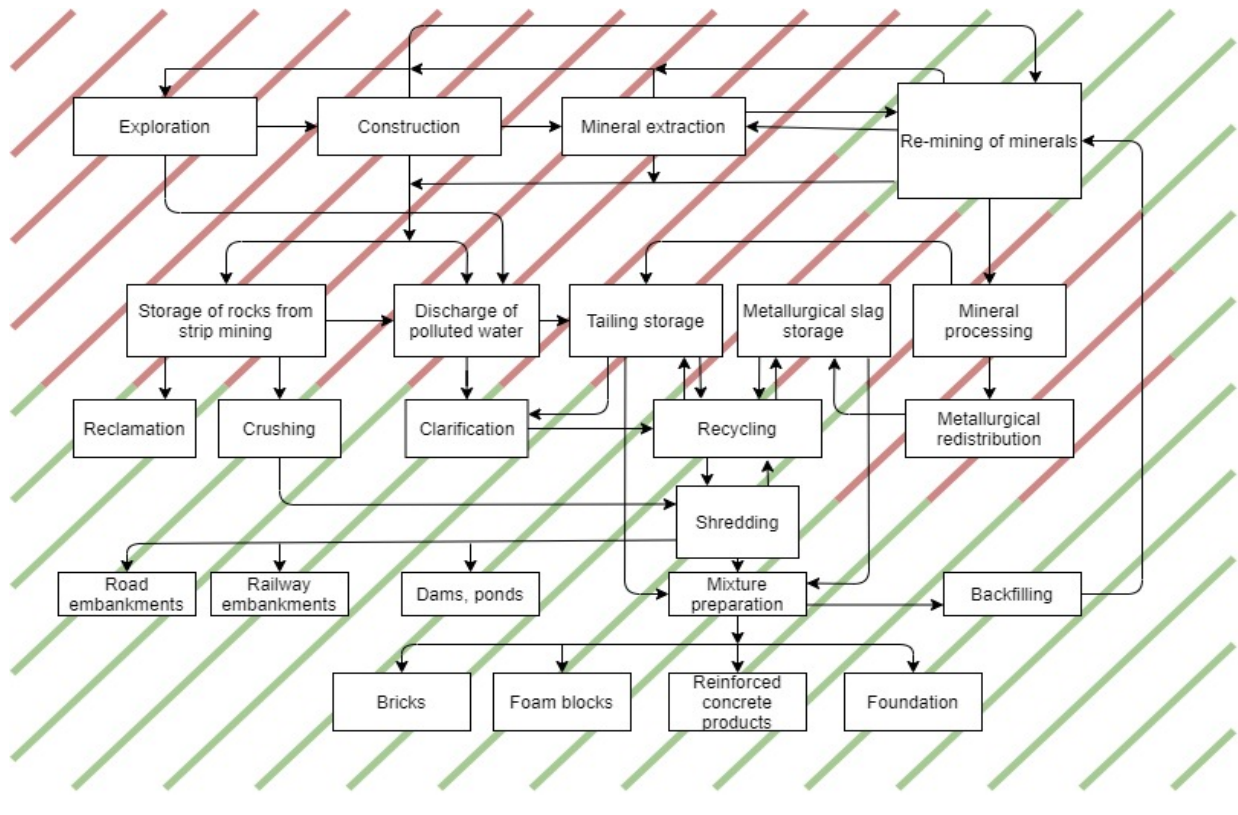
Figure 2. Organization scheme of the full cycle of mining and processing production. Zone of environmental safety Zone of environmental impact of an enterprise.